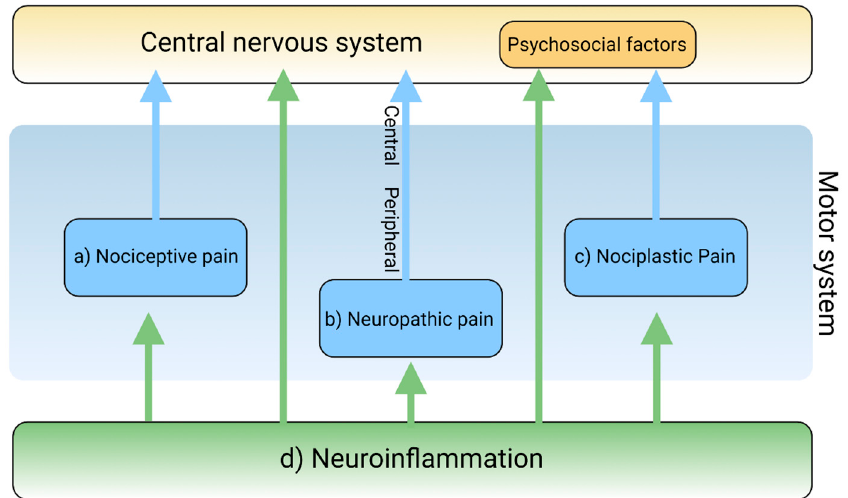
Figure 2. The main mechanisms of pain and the involvement of neuroinflammation. The mechanisms of pain are classified into ( a ) nociceptive, ( b ) neuropathic, and ( c ) nociplastic pain. Neuroinflamma- tion ( d ) is involved in each pain mechanism. Created with